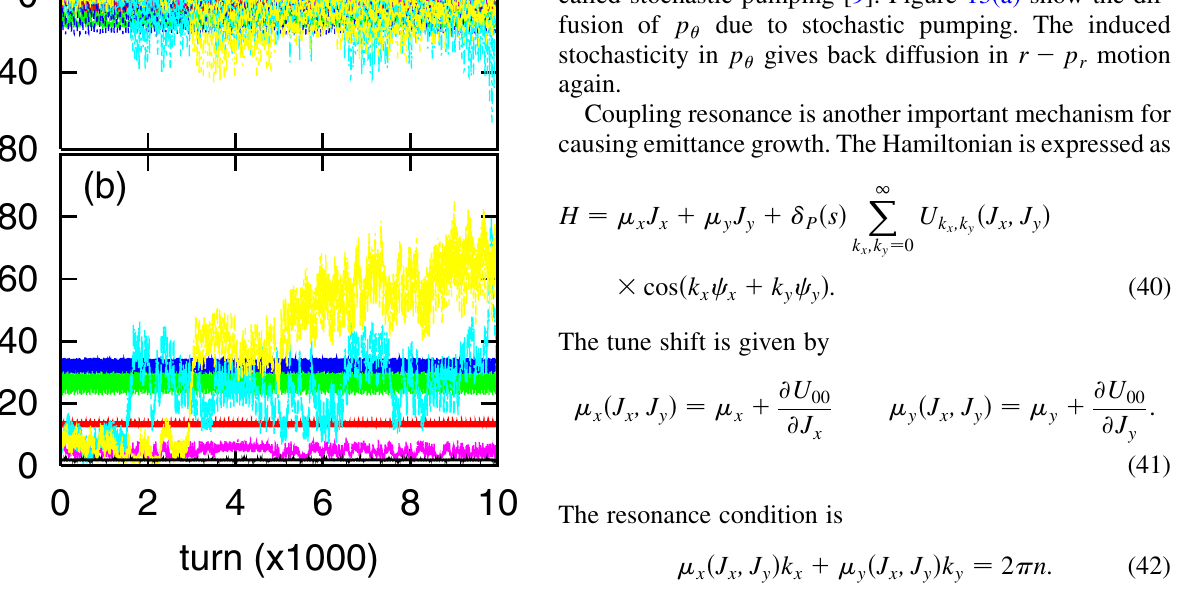
Fig. 6. Even if the p regular oscillation, stochasticity of r (cid:1) p hanced by the separatrix crossing.